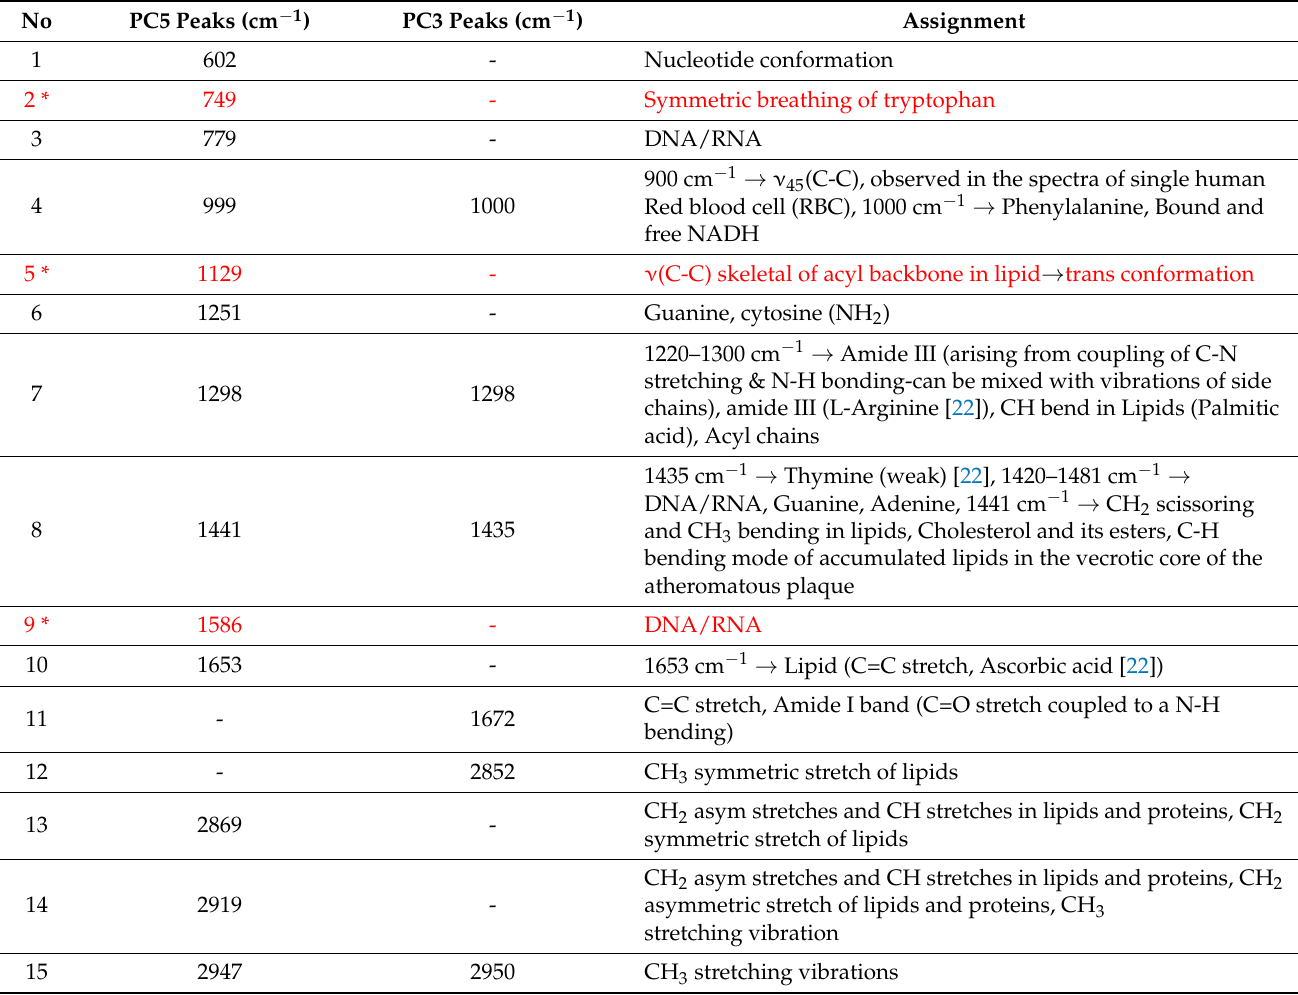
Table 4. Major Raman peaks found in PCA between BR2 and BR3, 4. In red color and with an asterisk superscript the temperature dependent Raman peaks are